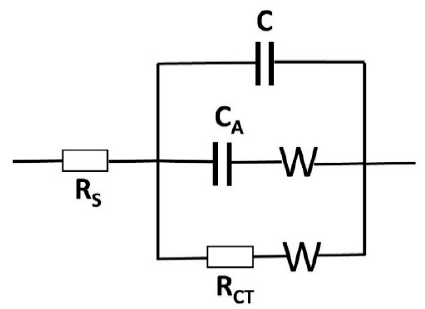
Figure 6. Equivalent electric circuit for the electrode impedance in case of adsorption of reactant. R S is the solution resistance, C is the double-layer capacity, C A is the adsorption “pseudocapacity”, and R CT is the charge transfer related to Equation (1). Ws are Warburg impedances representing the influence of diffusion. The working electrode is on the right lead of the circuit and the counter electrode on the left side.